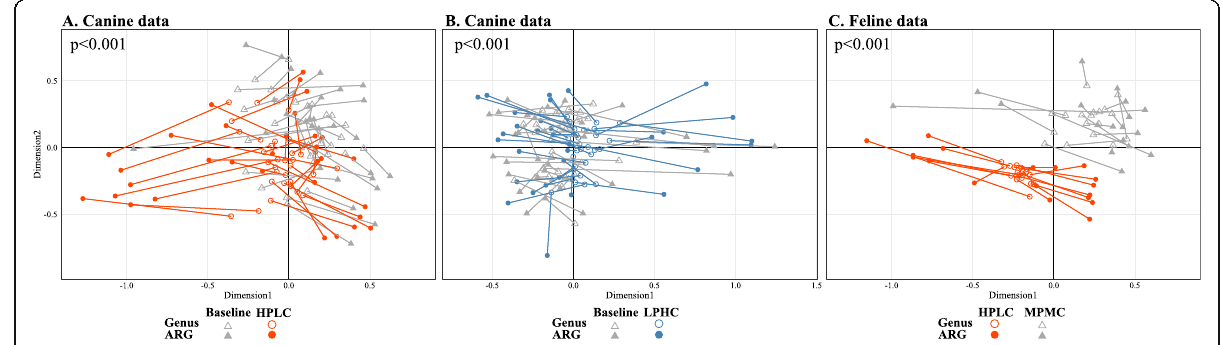
Fig. 4 Procrustes analysis of the association between ARG and taxonomic composition. Samples from the same animals are connected by a line, with hollow and filled points representing samples positioned by bacterial and ARG composition, respectively. In the canine data, red and blue circles represent samples with HPLC ( a ) and LPHC ( b ) diets, respectively, whereas grey triangles represent the baseline diet ( a and b ). In the feline data ( c ), red circles represent samples with HPLC diet, and grey triangles represent samples with MPMC diet. Taxonomic composition was assessed at the genus level. In both canine ( a and b ) and feline ( c ) data, there were statistically significant associations between ARG and taxonomic composition (all p < 0.001, procrustean randomization test), suggesting that gut bacteria and ARGs have similar clustering